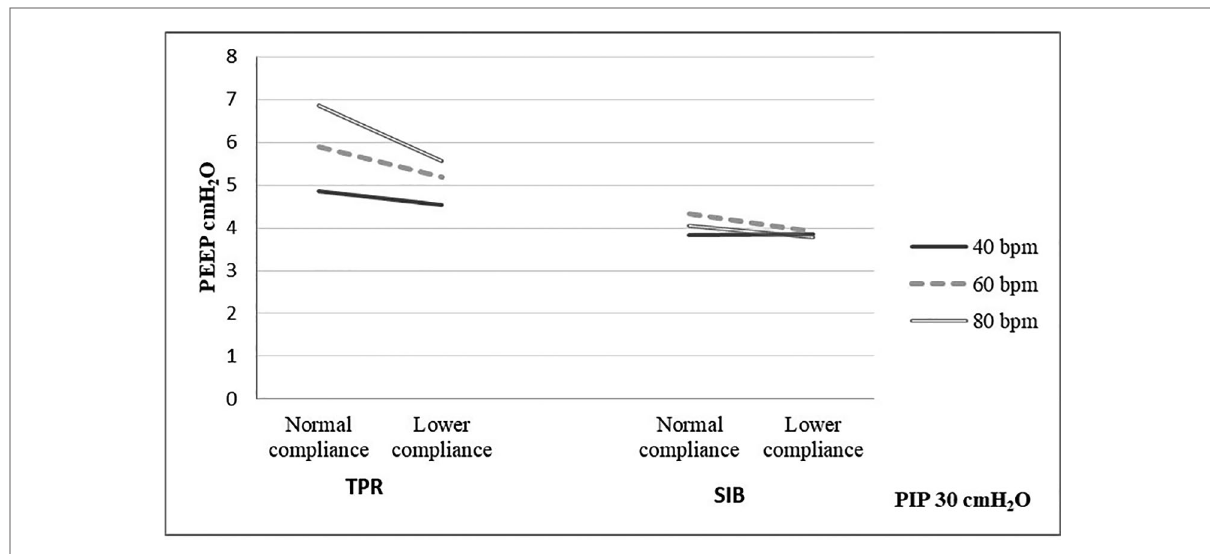
FIGURE 2 Measured PEEP using TPR and SIB at normal and lower compliance with PIP of 30 cmH 2 O.